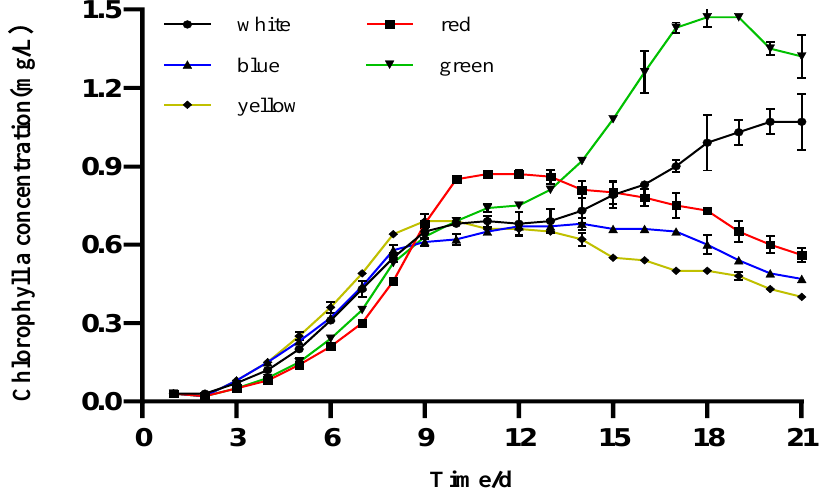
Figure 2. Daily mean values of chlorophyll- a in I. zhangjiangensis cultured under different colored LEDs (n = 3, p < 0.05 t -test).